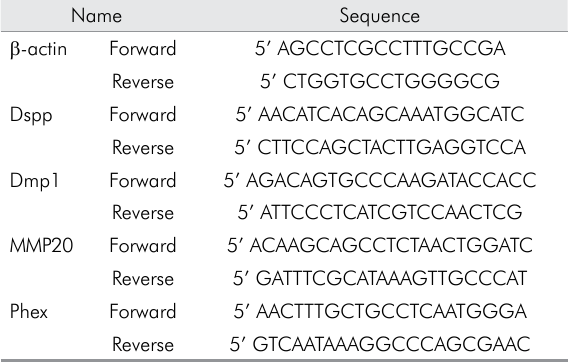
Table. Primer sequences (forward and reverse) used in